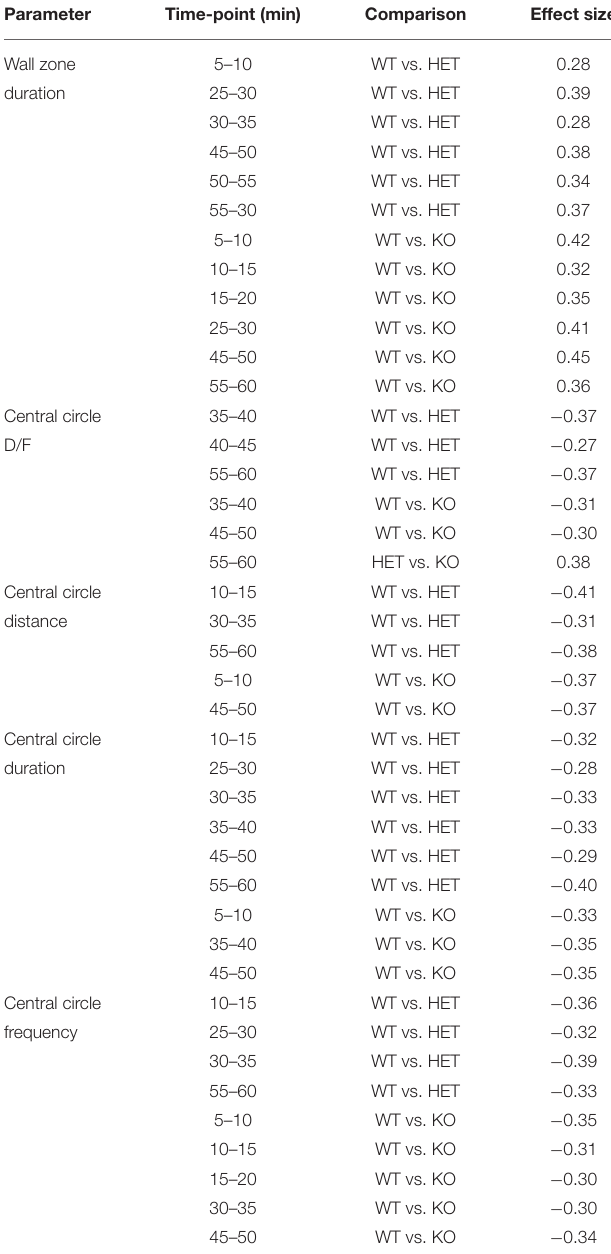
TABLE 2 | Calculated effect sizes for significant results in the OF test, ranging from small (0.1–0.3) to intermediate (0.3–0.5) effects (with no regard to minus sign; n = 25 WT, 28 HET, and 18